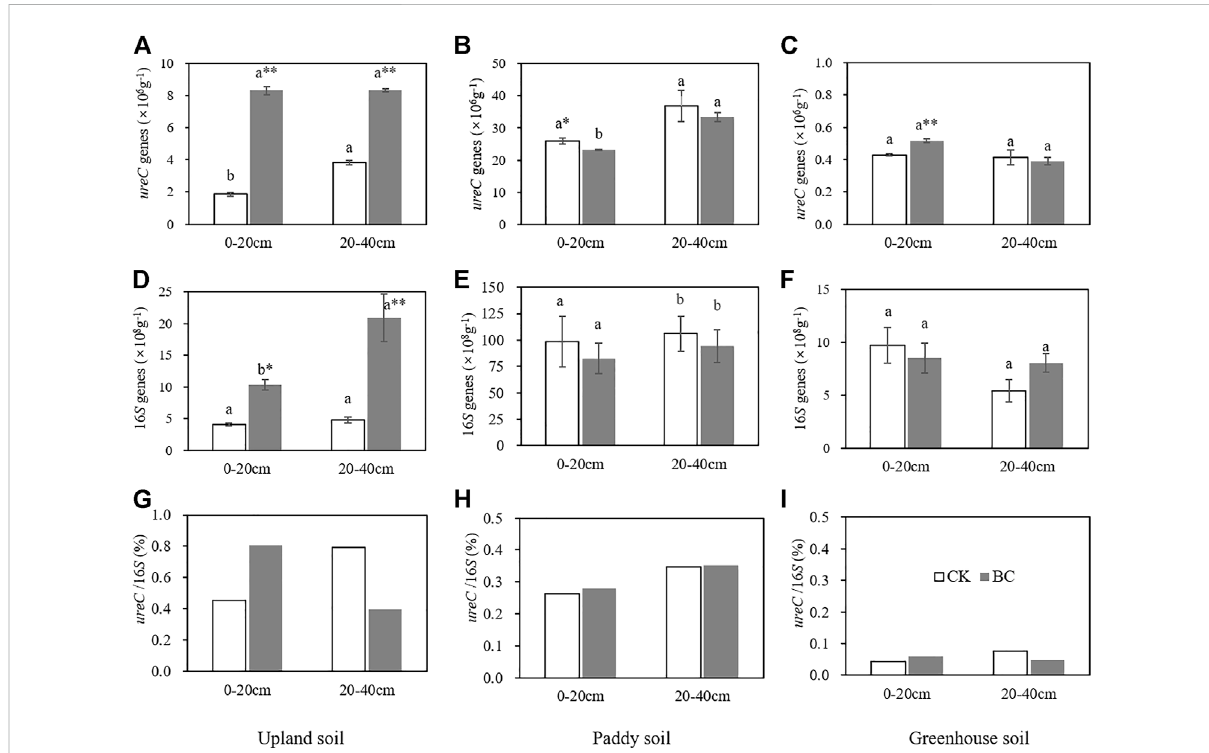
FIGURE 4 Thesoil ureC and16 S genecopynumbersandtheirratioinuplandsoil (A,D,G) ,paddysoil (B,E,H) andgreenhousesoil (C,F,I) .Barsrepresentthe standard error of the mean. Different lowercase letters indicate signi fi cant differences between 0 – 20 and 20 – 40 cm soil layer, the * and **indicate signi fi cant differences between the control and biochar treatments within same soil depth at p < 0.05 and 0.01, based on an independent t